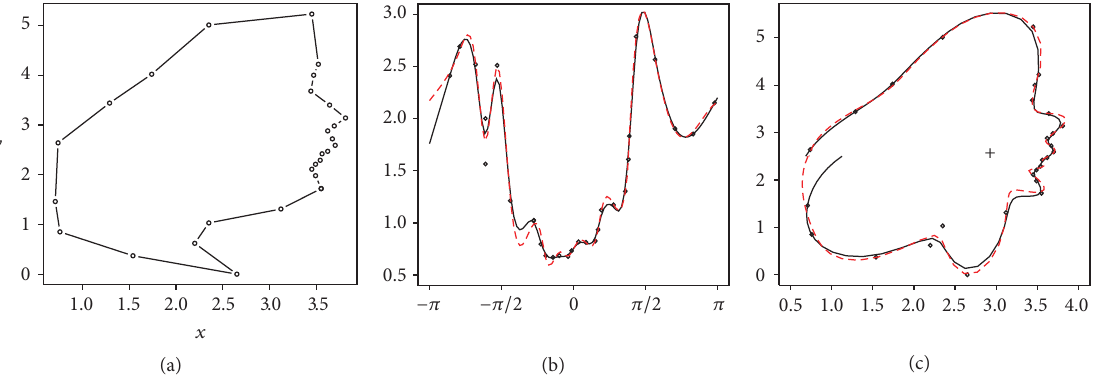
Figure 7: (a) Face data; (b) polar coordinate data with fitted spline curves; (c) back-transformed fitted curves. In (b) and (c) the solid curves use standard splines, whereas the dotted use periodic splines.